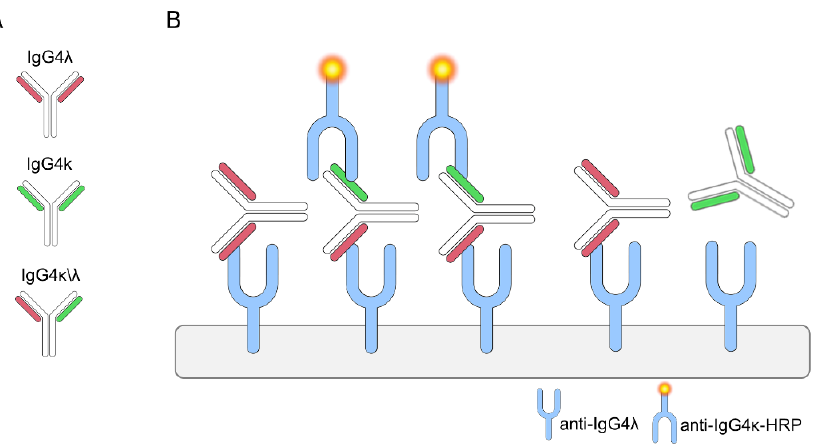
Figure 1. Schematic representation of IgG4 k/ λ ( A ) and of the Binding site assay used for the measurement of hybrid levels ( B ).